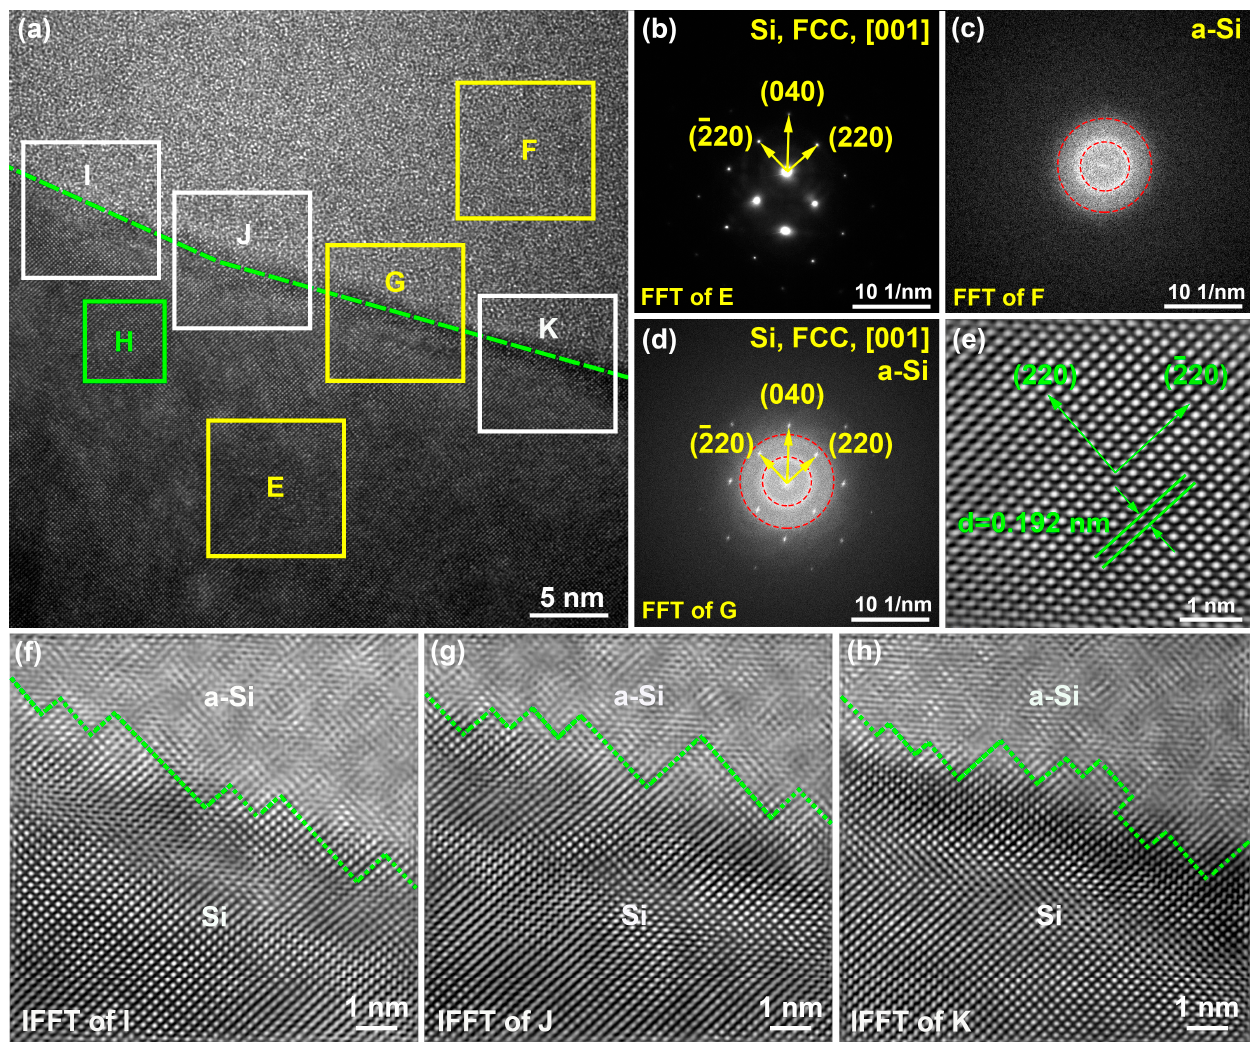
Figure 6. HRTEM analysis of the transition layer of Figure 5f. ( a ) HRTEM image of the Si and a-Si interface; FFT images of regions ( b ) E, ( c ) F, and ( d ) G; ( e ) IFFT image of region H; IFFT images of regions ( f ) I, ( g ) J, and ( h ) K.